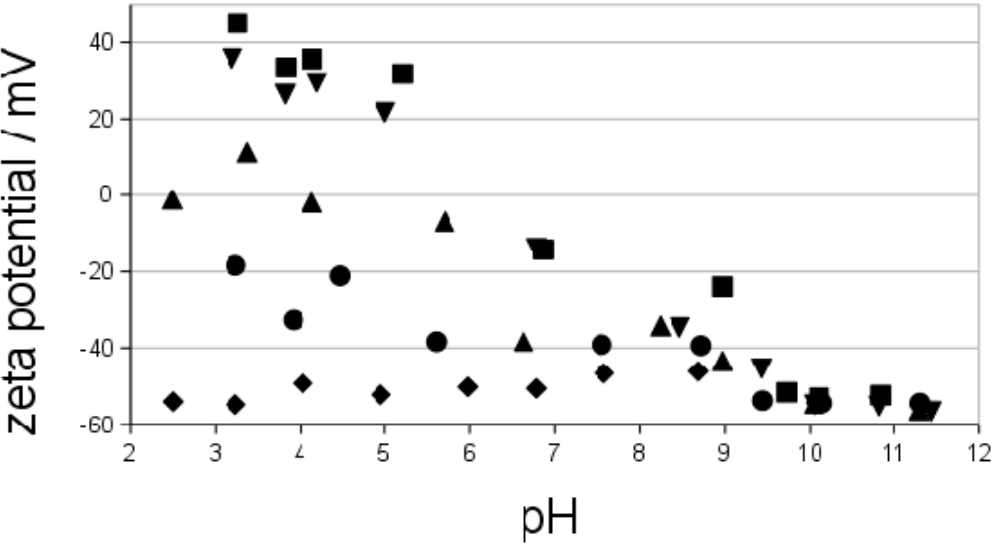
Figure 1. The zeta potentials of titania in 10 − 3 M NaCl at various concentrations of sodium octadecyl sulfate in 5% ethanol. ■ 0, ▼ 1.1 × 10 − 6 , ▲ 5.4 ∙ × 10 − 6 , ● 1.1 ∙ × 10 − 5 , ♦ 2.1 × ∙ 10 − 5 M sodium octadecyl sulfate.